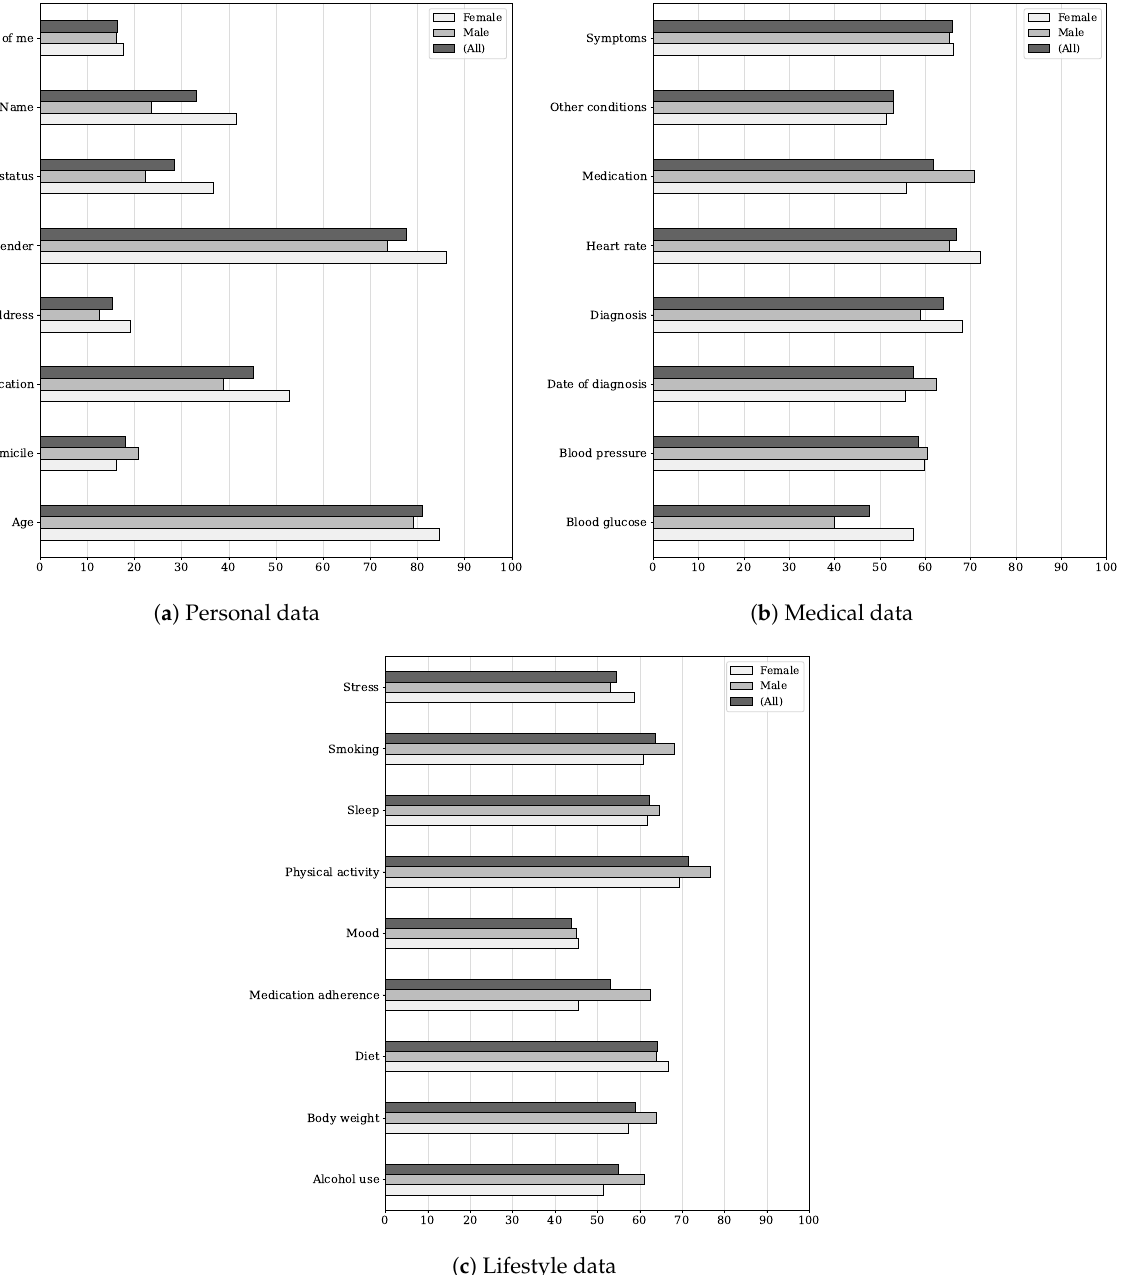
Figure 2. Mean ratings for ( a ) personal, ( b ) medical, and ( c ) lifestyle data items. Here, 0 indicates very unlikely to share, while 100 indicates the exact opposite, i.e., very